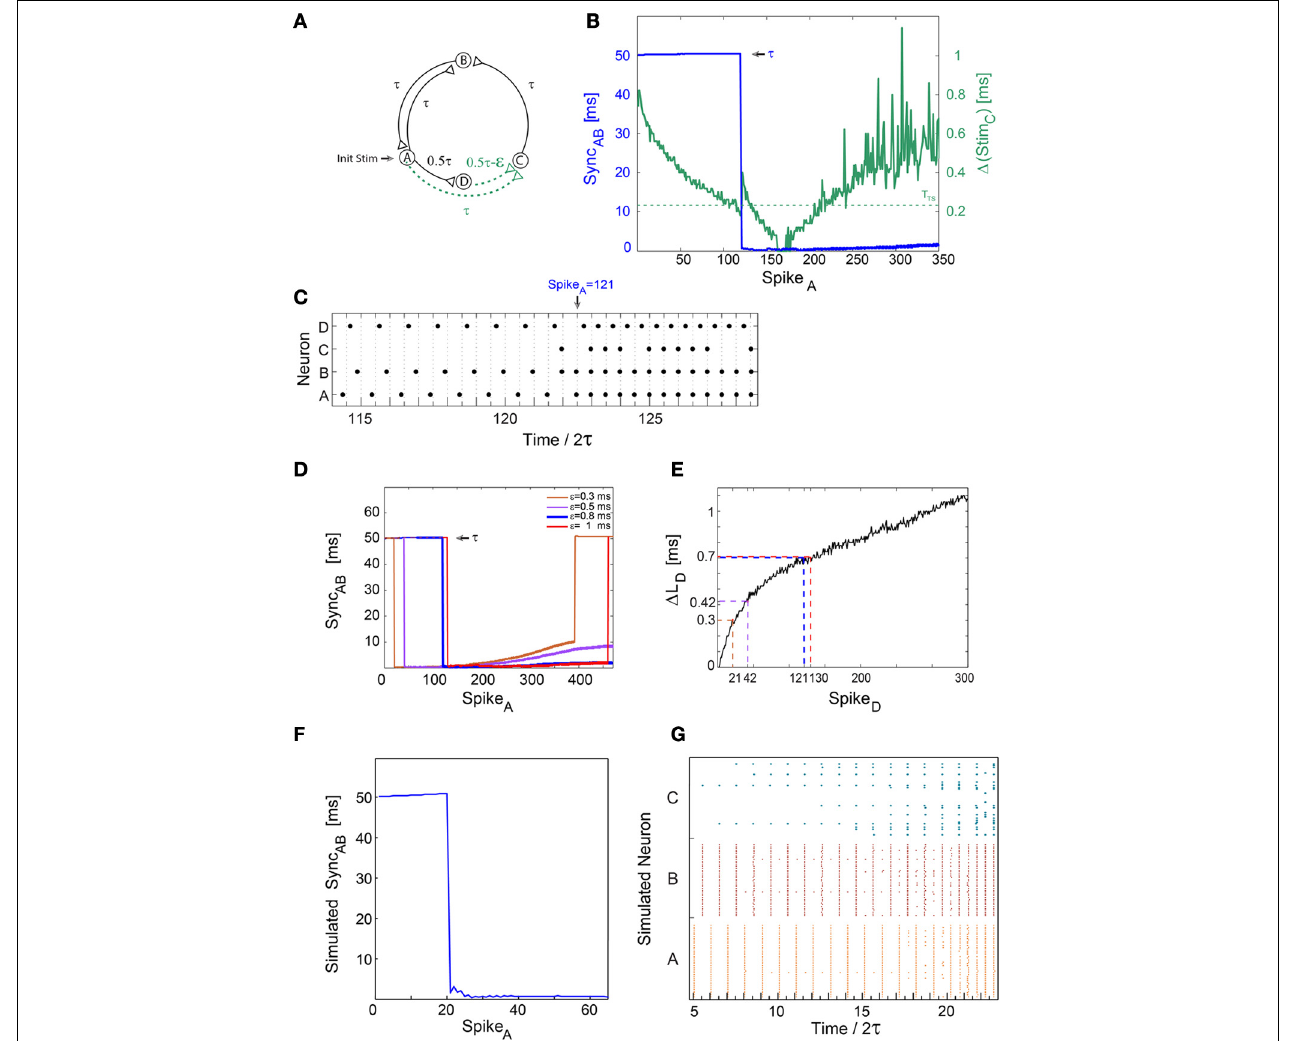
firing frequency, from ∼ 10 to ∼ 20Hz. Sync AB ≈ 0 is robust to response failures of neuron C, e.g., time/2 τ = 124 . 5. (D) Sync AB as a function of the spikes of neuron A, for various ε , where the data for ε = 0 . 8 (blue) is the same as in (B,C) . The number of spikes to a leap to synchrony increases with (cid:2) L ε . (E) (cid:2) L D for repeated stimulations at 10Hz. D at the synchrony leap for different ε are colored following (D) . Note that Spike D is equal to Spike A in (B , D) . (F) Results of population dynamic simulations where each neuron in (A) is now represented by a population comprised of 40 Hodgkin-Huxley neurons, each one innervated by four randomly chosen neurons from each of its driving clusters. The delays between neurons are taken from a Gaussian distribution centered at the delays of the single neuron case with a variance of 0.2ms. For simplicity, each time a neuron fires all of its outgoing delays are increased by 0.04ms. The simulation parameters were ε = 2ms and T TS ≈ 1 . 3ms. (G) Raster plot of the 120 neurons comprising nodes A, B, and C. A leap to synchrony occurs at time/2 τ ≈ 20, accompanied by a doubling of the firing